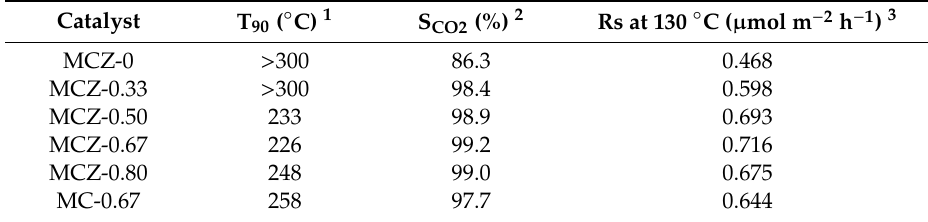
Figure 7. The catalytic activity of MCZ-x (x = 0, 0.33, 0.50, 0.67, 0.80) and MC-0.67 catalysts for chlorobenzene (CB) combustion; gas composition: 1000 ppm CB, 21% O 2 ; gas hourly space velocity (GHSV) = 20,000 h − 1 . Table 3. Results of activity tests on CB combustion over the prepared catalysts.